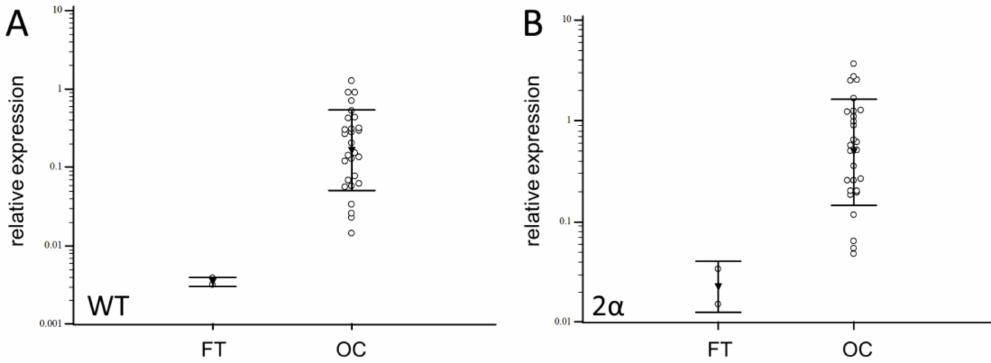
Figure 6. Relative expression of S WT ( A ) and S 2 α ( B ) in fallopian tube (FT) and ovarian carcinoma (OC)